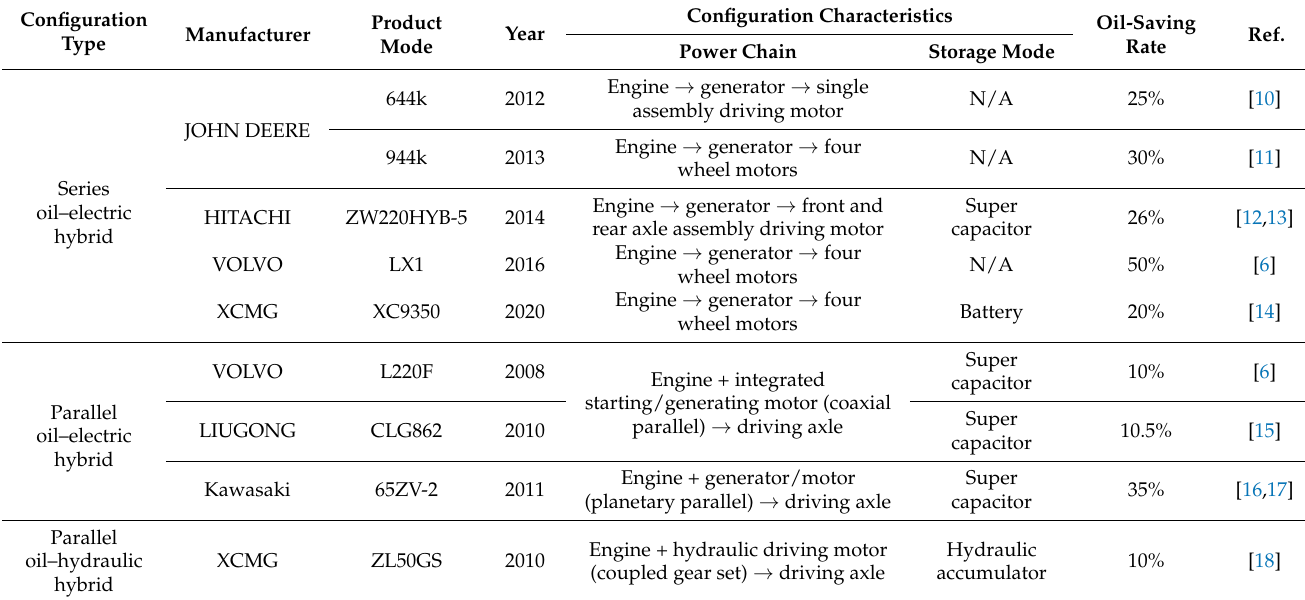
Table 1. Application status of drivetrain configuration of